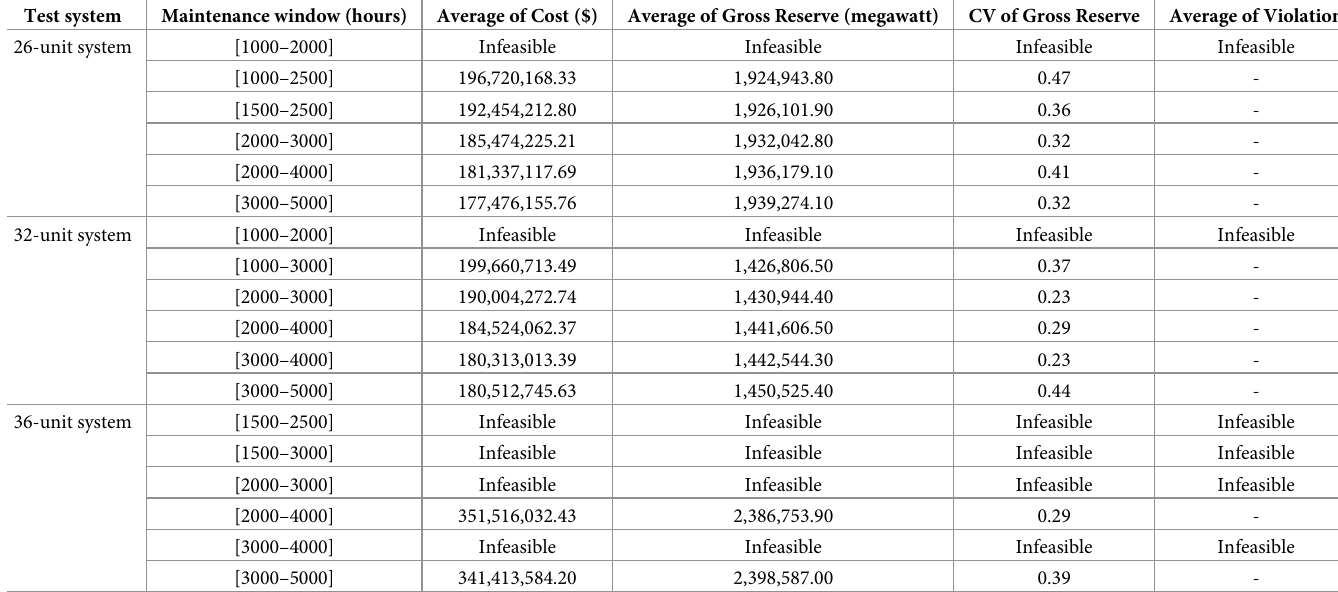
Table 8. Results of GMS model II.